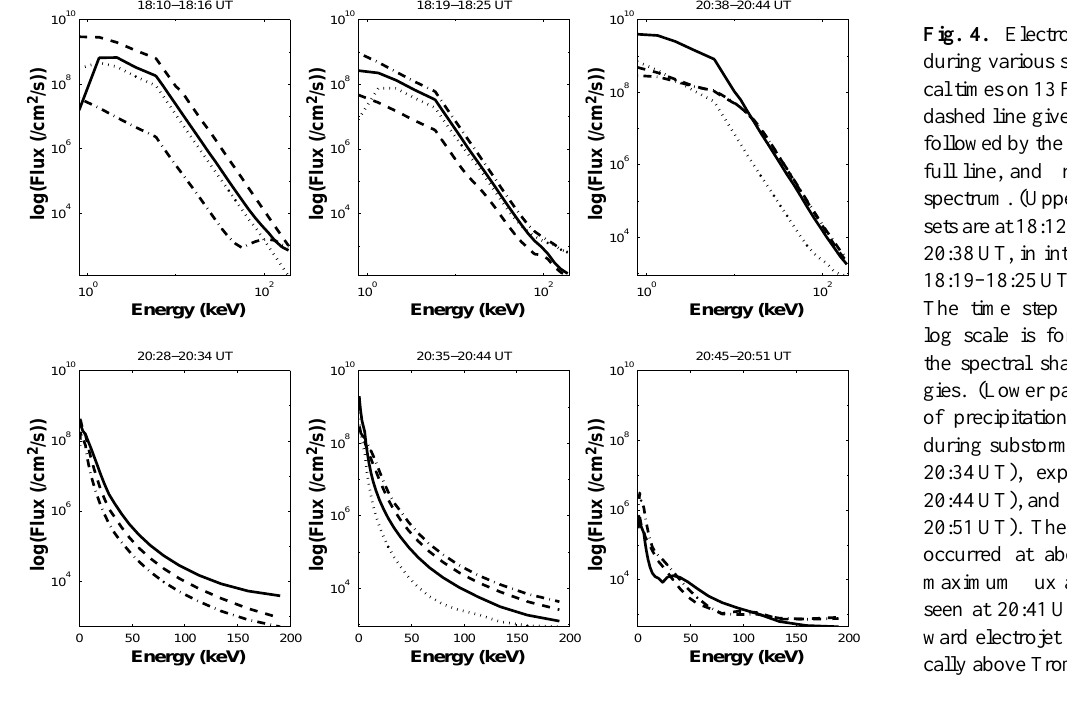
Fig. 4. Electron precipitation spectra during various substorm phases and lo- cal times on 13 February 1996. The dot- dashed line gives the earliest spectrum, followed by the dashed line, then by the full line, and finally by the dotted line spectrum. (Upper panels) Substorm on- sets are at 18:12UT, at 18:21UT, and at 20:38UT, in intervals 18:10–18:16UT, The time step is 2min and the log- log scale is for better recognition of the spectral shapes at the lower ener- gies. (Lower panels) Typical sequence of precipitation spectra, every